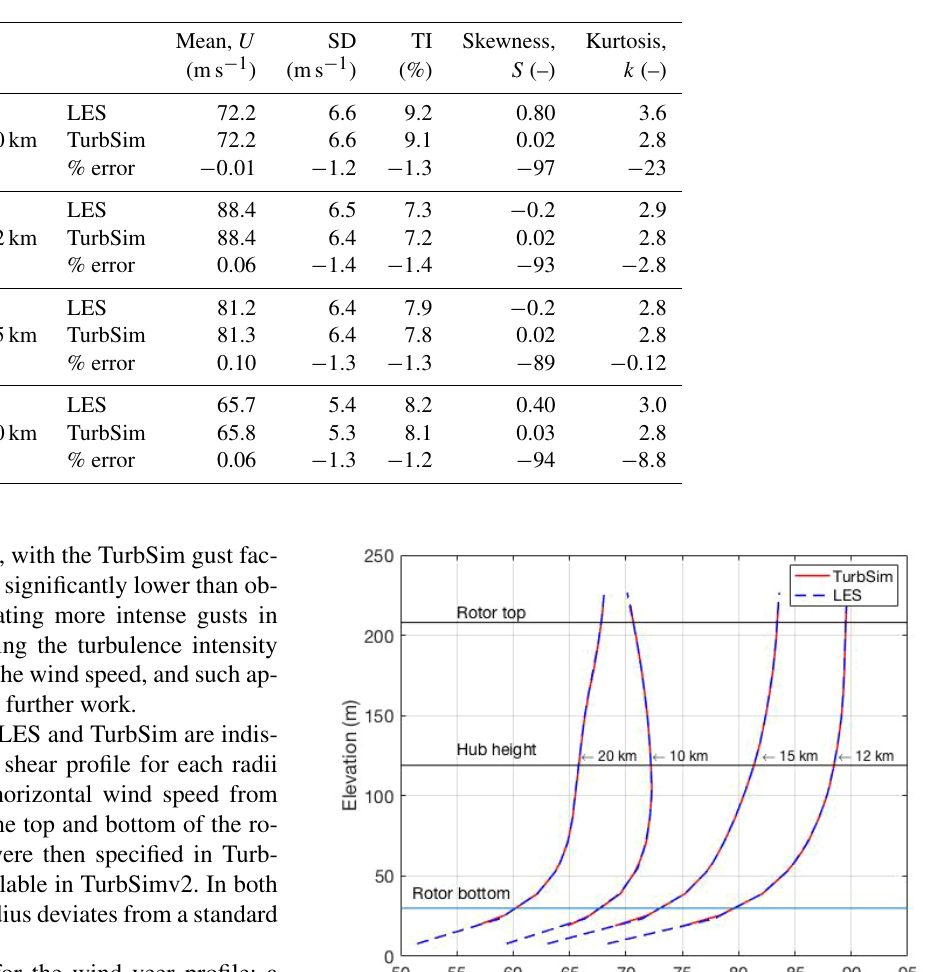
Table 2. Comparison of LES and TurbSim wind field statistics.